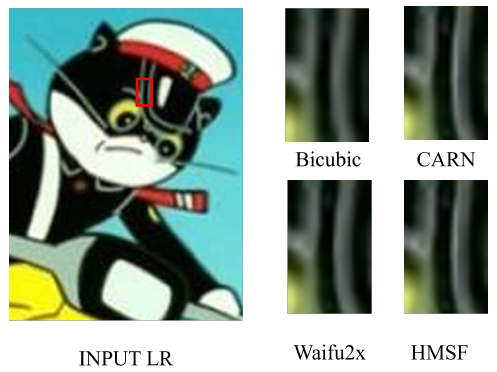
Figure 15. Visual test on real-world historical image of 2 × .